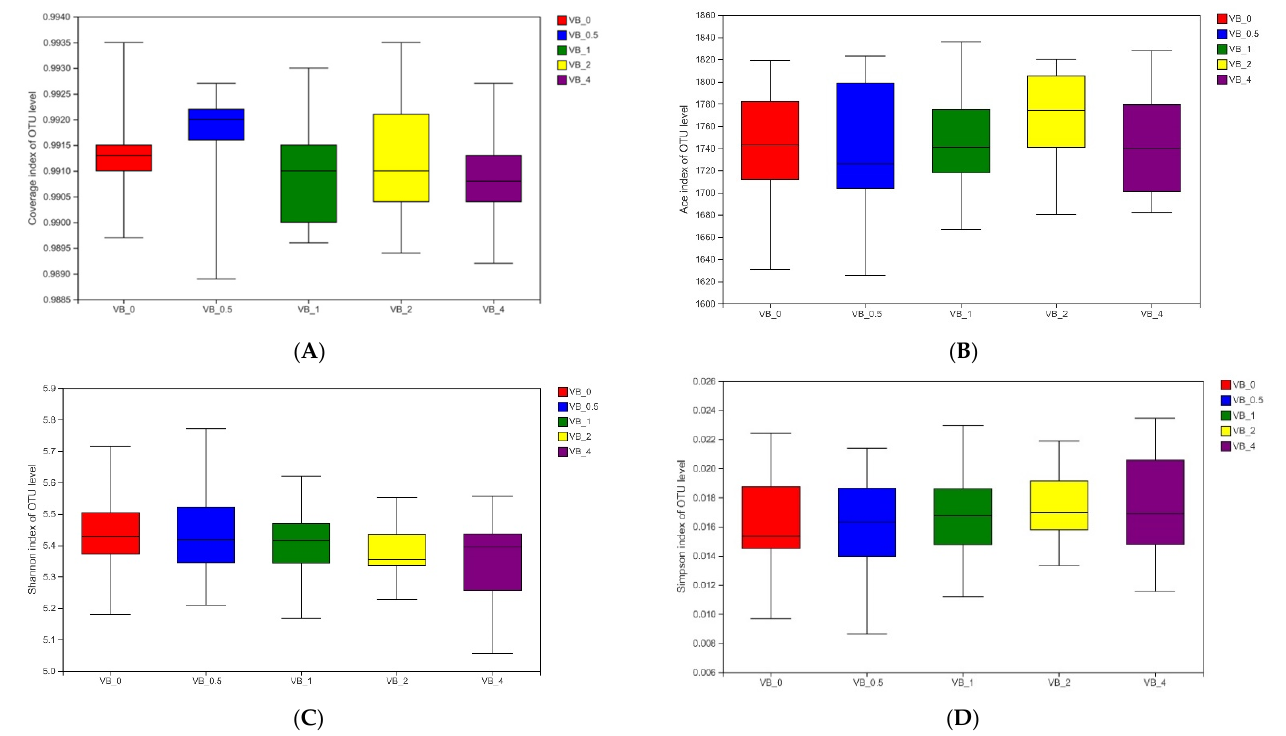
Figure 1. Changes of alpha diversity indices in the bacterial community in the rumen fermentation system with increasing vitamin B 12 supplementation. ( A ) Coverage index; ( B ) Ace index; ( C ) Shannon index; ( D ) Simpson index.